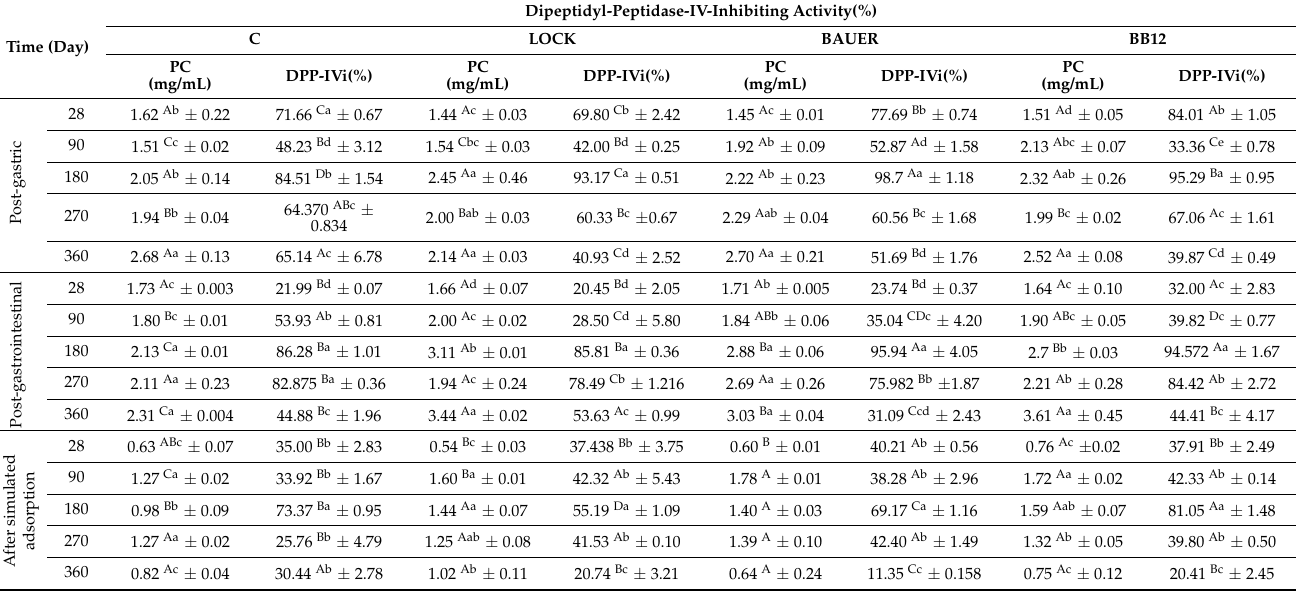
Table 3. Dipeptidyl peptidase IV inhibiting activity (DPP-IVi; %) and peptides concentration (PC,